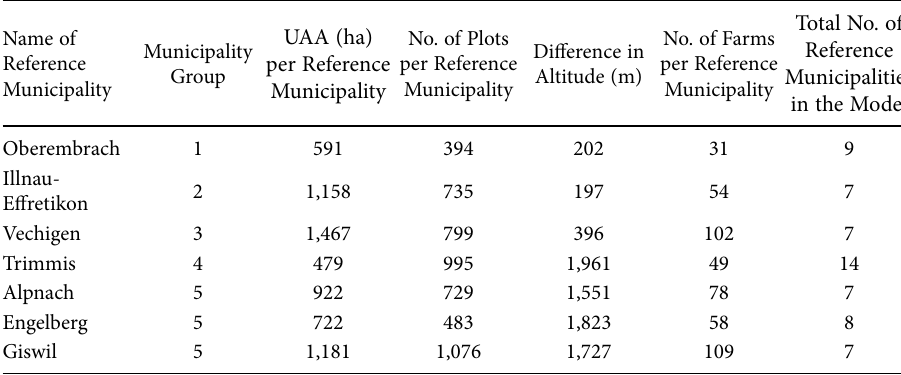
Table 2. Features of the reference